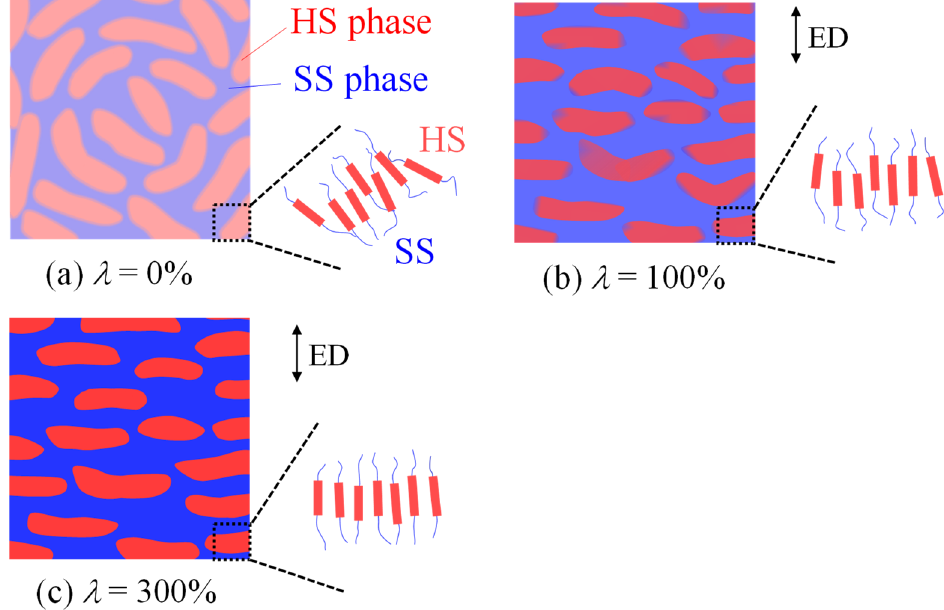
Figure 6. Schematic illustration of the heat-elongated TPU films obtained at 150 °C at various elongation ratios λ : ( a ) λ = 0%, ( b ) λ = 100%, and ( c ) λ = 300%. The contrast becomes stronger as the density difference increases.